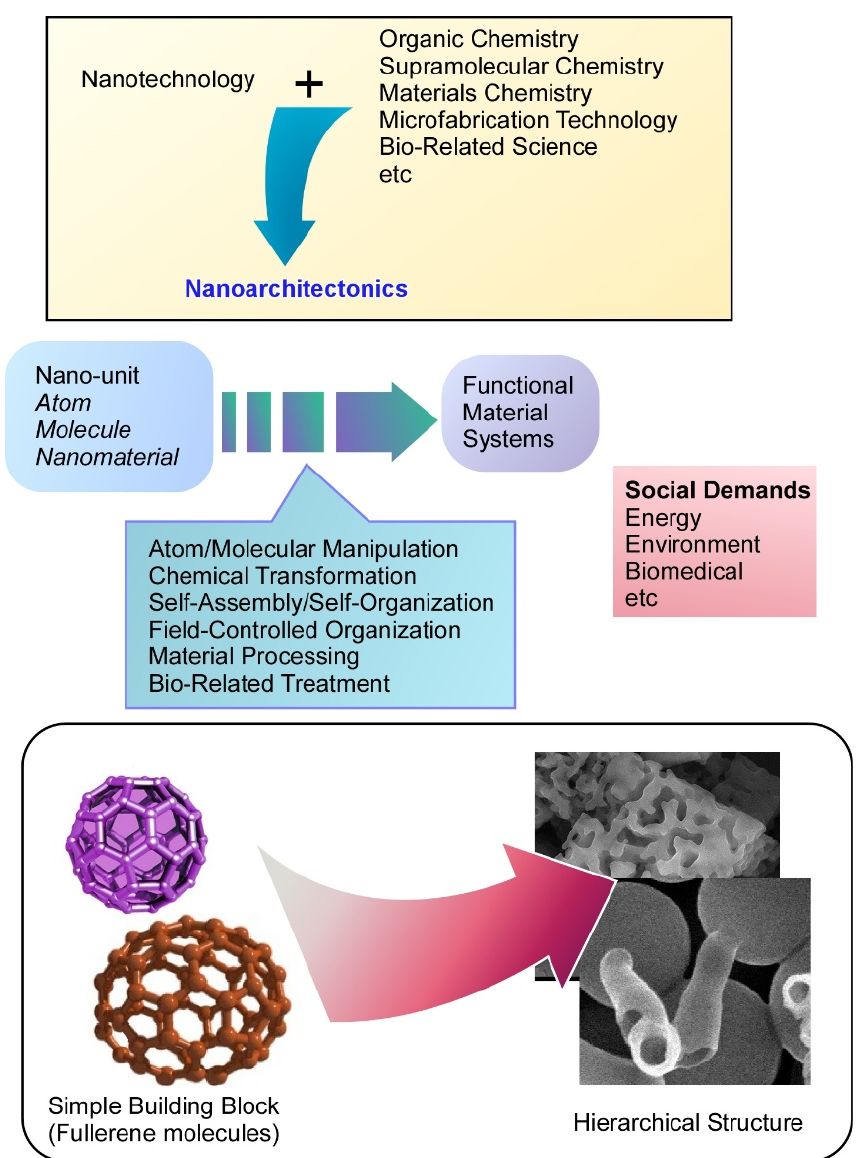
Figure 1. Nanoarchitectonics is a conceptual methodology to combine nanotechnology with other research fields, in which functional material systems are prepared from nanoscale units.